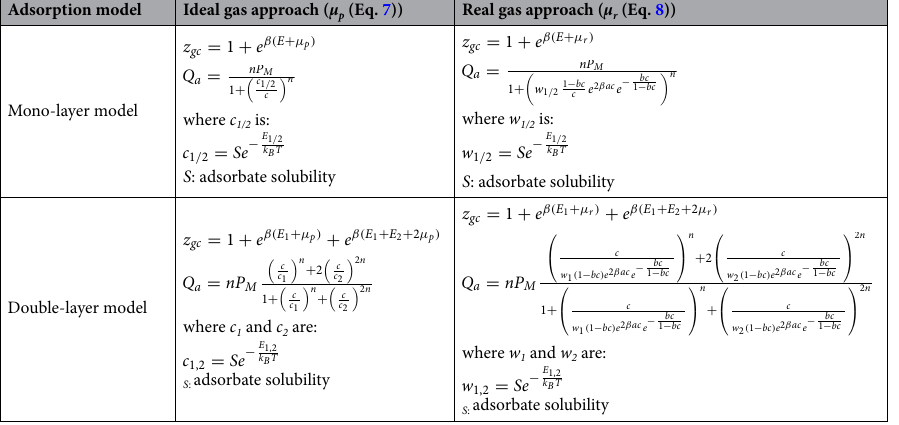
Table 1. Analytical expressions of the grand-canonical partition function ( z gc ) and the adsorbed quantity ( Q a ) corresponding to the two mono-layer models of ideal gas and real gas and the two double-layers models of ideal gas and real